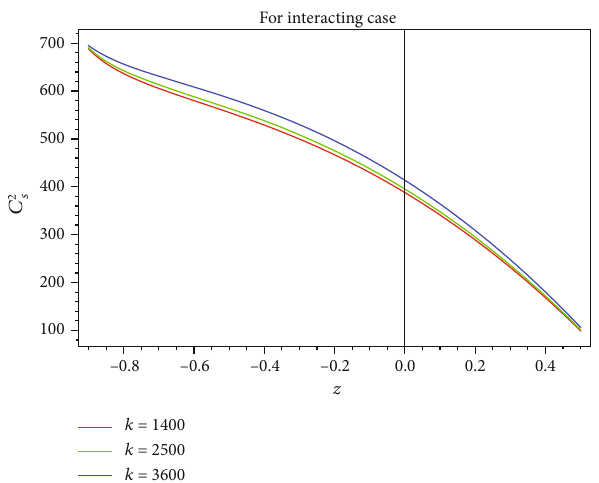
Figure 7: Variation of squared speed of sound C 2 parameter z .